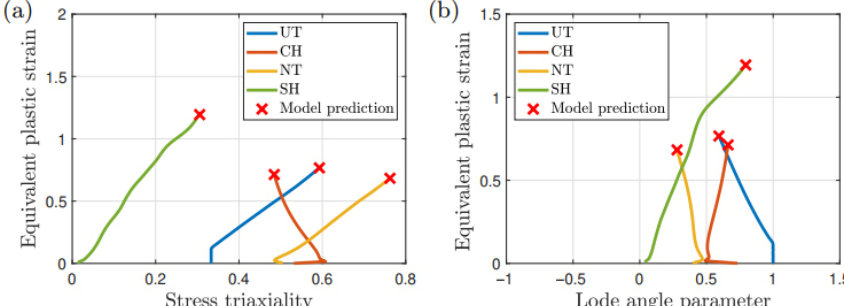
Fig. 5 Evolution of effective plastic strain as a function of (a) stress triaxiality and (b) Lode angle parameter. The red crosses represent the equivalent plastic strain values at the onset of